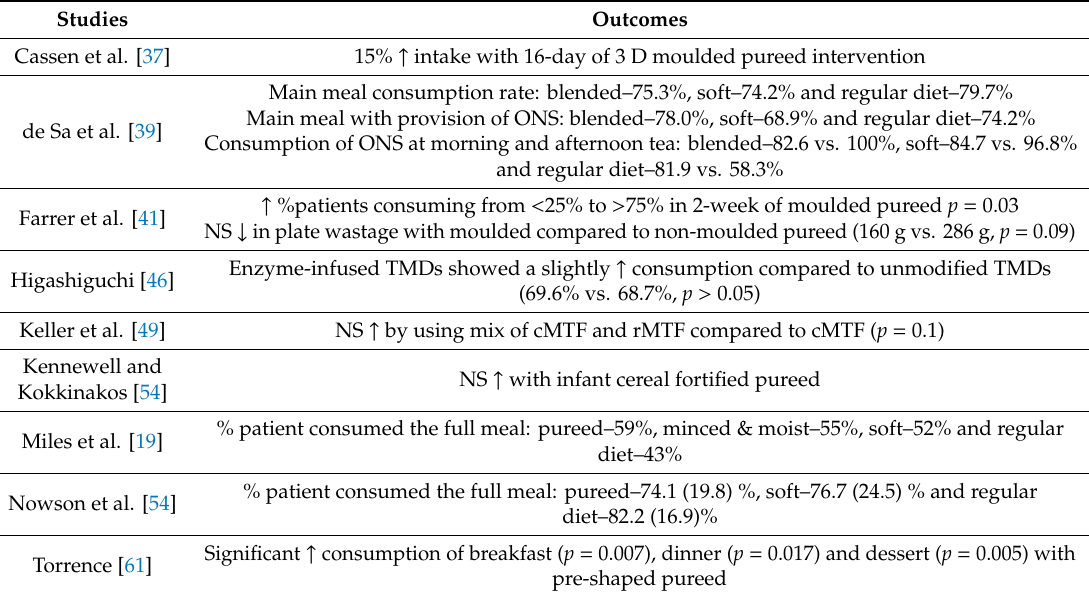
Table 2. Outcome data for studies assessing patient meal